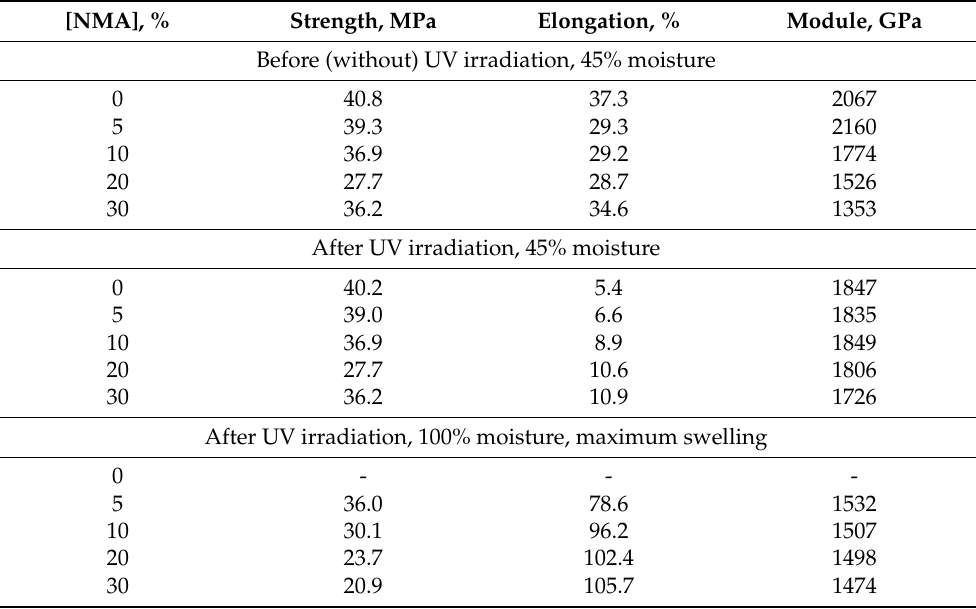
Table 2. Strain and strength characteristics of the films from chitosan with a content of NMA of 5–30 wt% obtained at different conditions. [NMA], % Strength, MPa Elongation, % Module, GPa Before (without) UV irradiation, 45% moisture 0 40.8 37.3 39.3